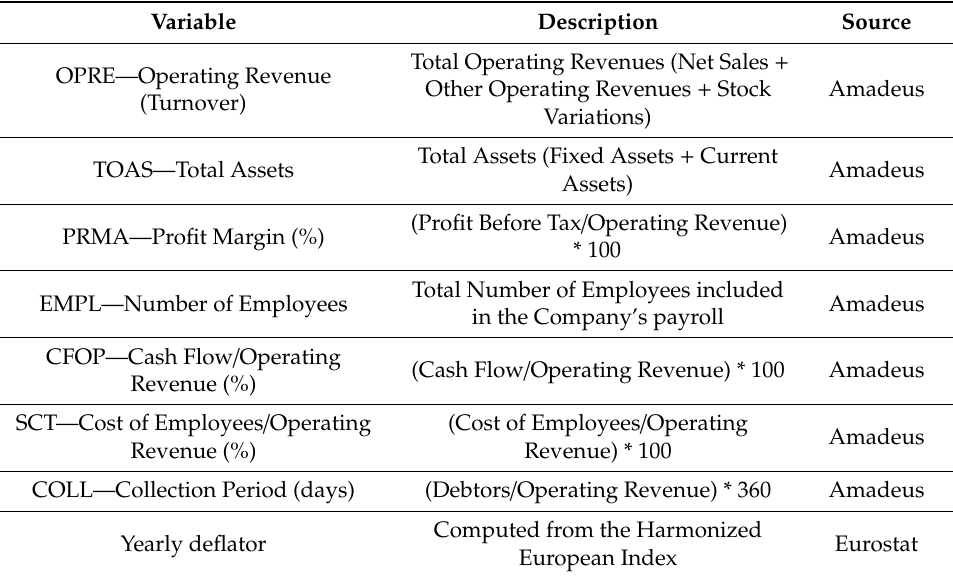
Table A1. Variables definition and